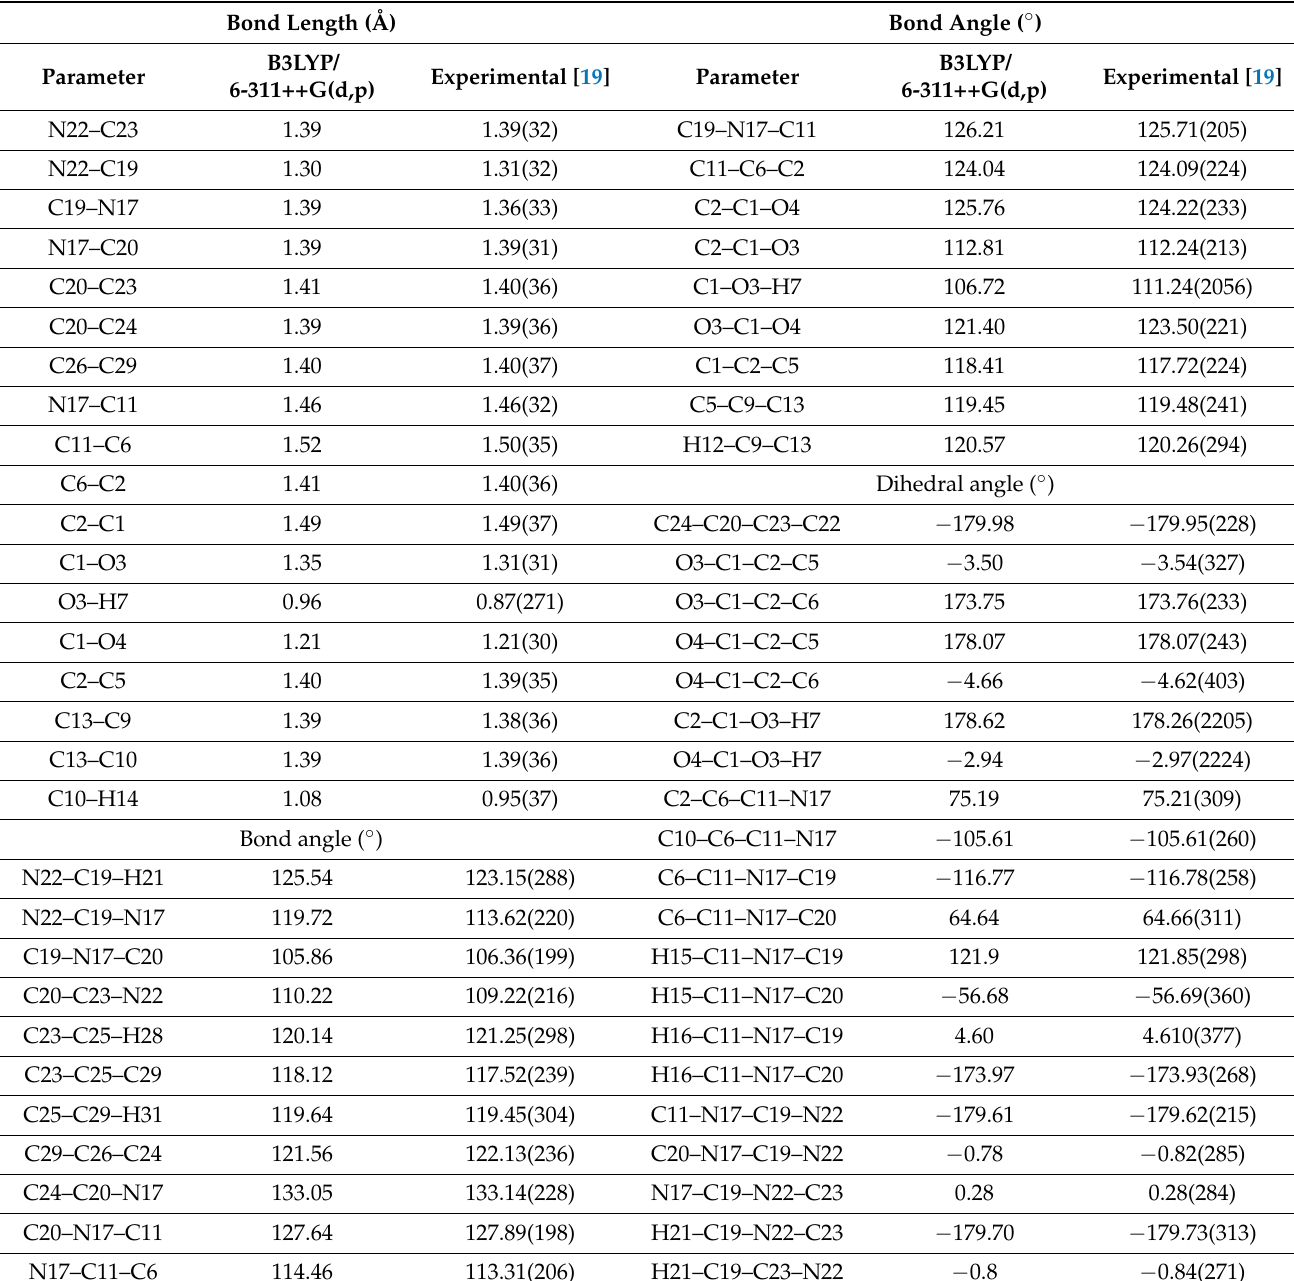
Table 1. Optimized geometrical parameters of 21HBMBA in gas phase: bond length (Å) and bond angles ( ◦